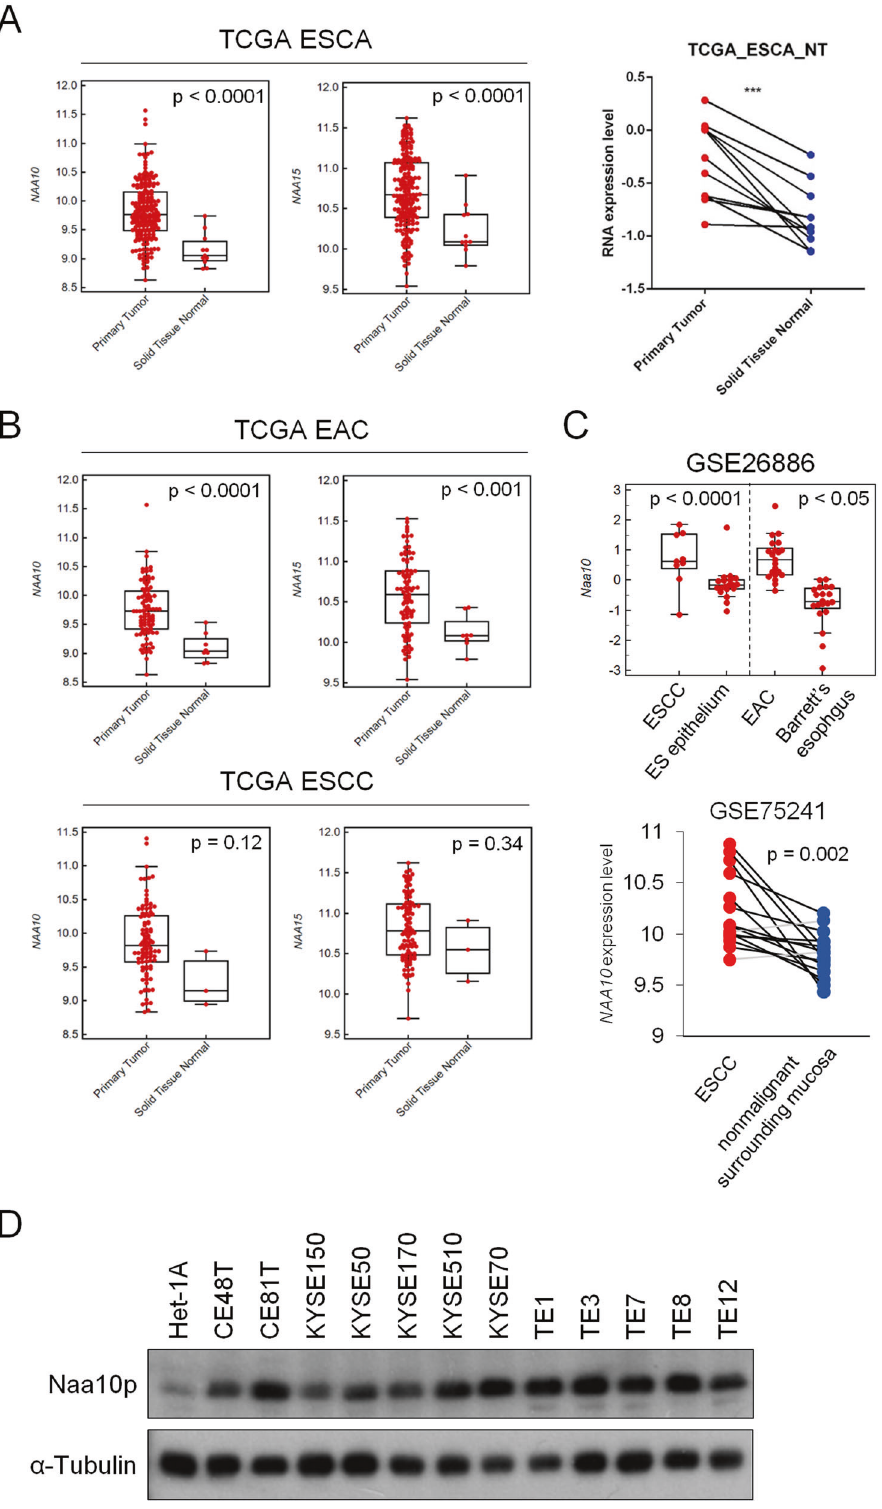
Fig. 1 NAA10 is highly expressed in both esophageal adenocarcinoma (EAC) and esophageal squamous carcinoma (ESCC). A Left panel: Comparison of NAA10/15 expression levels between ESCA and normal tissues. Right panel: Comparison of NAA10/15 expression levels in paired ESCA and adjacent normal tissues. B Comparison of NAA10/15 expression levels between cancerous and normal tissues. Upper panel: EAC, lower panel: ESCC. C Comparison of NAA10 expression levels between cancerous, premalignant, and normal tissues. D Western blot analysis of Naa10p in ESCA cell lines and immortalized ES epithelial cell line, Het-1A.